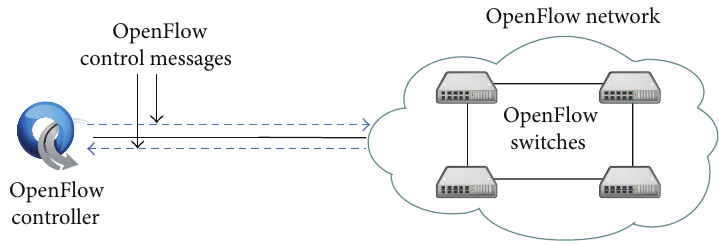
Figure 1: The architecture of OpenFlow network.